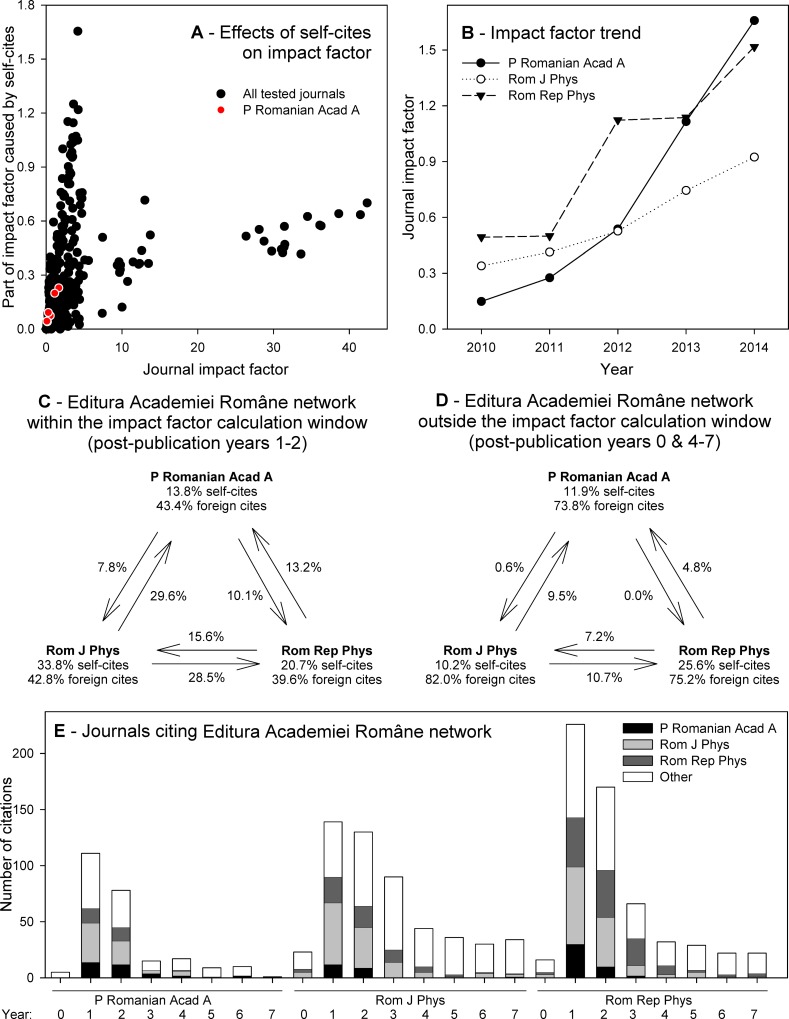
Kinetics of citations to articles in three Romanian physics journals published by Editura Academiei Române.(A) Journal impact factor plotted against the part of impact factor caused by self-cites, analyzed individually for the 60 journals examined in course of this study in each year for which the JCR data were available in 2007–2014 (black circles), with highlighted position of Proceedings of the Romanian Academy, Series A (red dots). (B) Changes in JCR impact factor of the three journals published by Editura Academiei Române. (C-D) Scheme of the Editura Academiei Române network within the impact factor calculation window, i.e., in post-publication years 1–2 (C) and outside the impact factor calculation window, i.e., in post-publication years 0 and 4–7 (D). (E) Annual number of citations received by the three physics journals published by Editura Academiei Române from their network, matched with foreign citations.